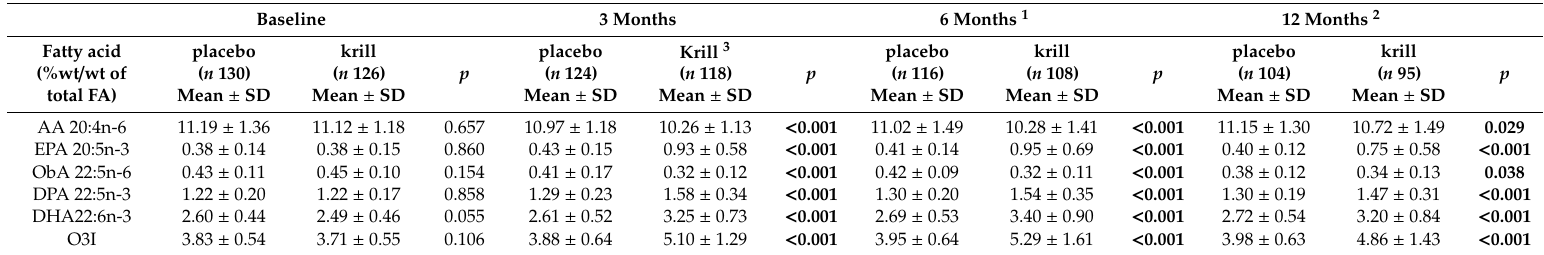
Table 2. Fatty acids in blood at di ff erent time points in intention-to-treat analysis. Baseline